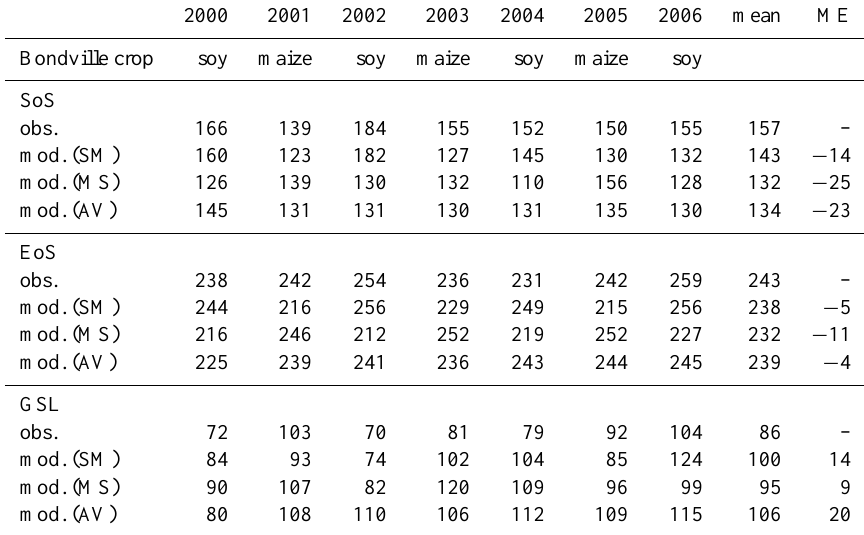
Table 2. Observed (obs., at Bondville) and modelled (mod.) start of season (SoS), end of season (EoS) DOYs, and growing season length (GSL) in days. Model data (experiment DAmod) are shown for pixels with soybean grown in even years (soybean–maize (SM), as Bondville site rotation), with soybean grown in odd years (maize–soybean (MS)), and averaged over all pixels (AV). ME = mean error (mod. −